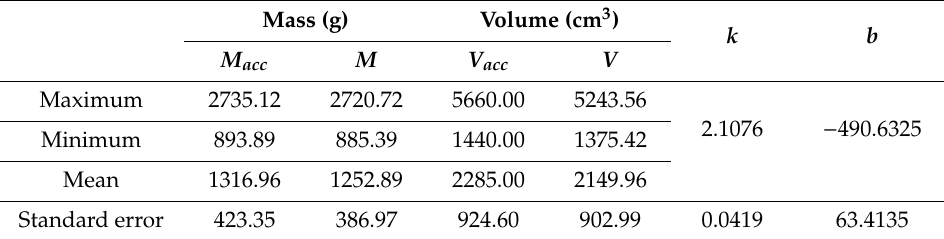
Table 2. Comparison of measured and estimated values for mass and volume.